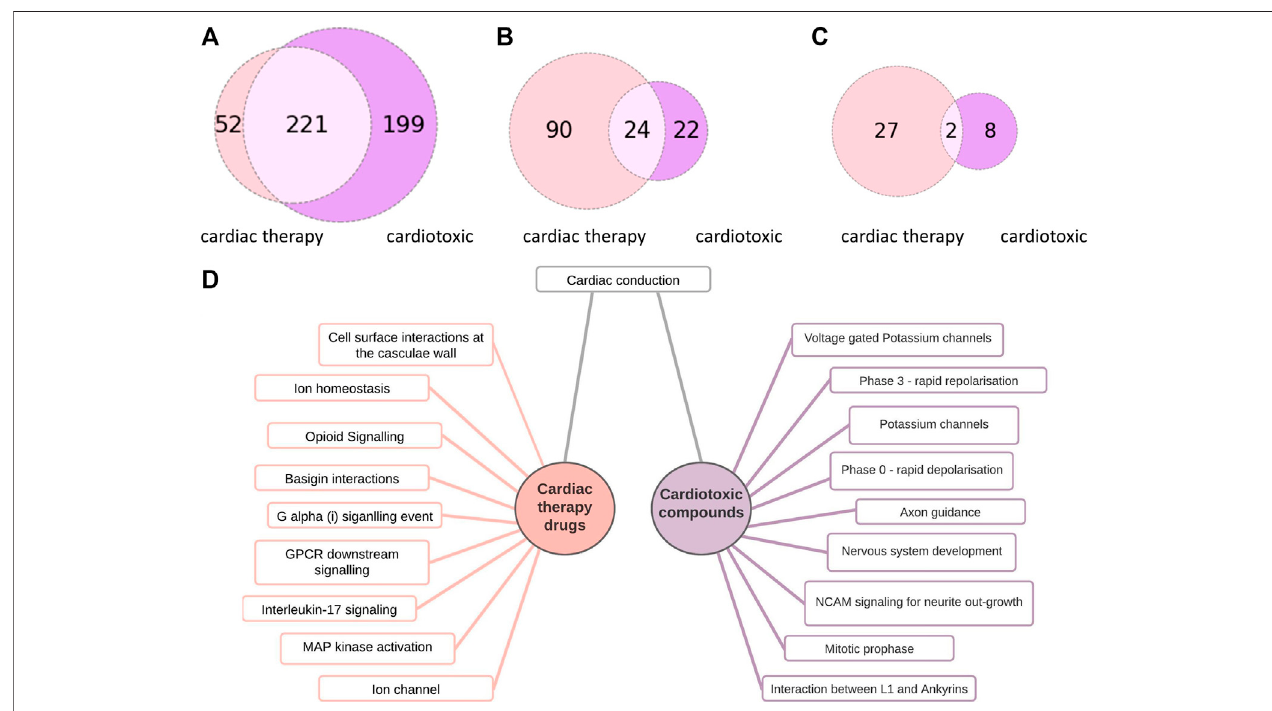
FIGURE 5 | Comparison ofpathways connected to cardiac therapy drugs and cardiotoxic drugs (A) : Number of pathway connections with an FDR cut-off of 0.05 between thecardiac therapy (light pink) and thecardiotoxic (purple) groups, (B) : Number ofpathwaysaffected by at least 10% ofcardiac therapy (light pink) and at least 10%ofcardiotoxiccompounds (purple),24commonpathways (C) :Numberofpathways affectedbyatleast20%ofcardiactherapy(lightpink) andatleast20%ofthe cardiotoxic (purple) compounds, 2 common pathways (D) :10 of the most often occurring pathways connected to cardiac therapy drugs (left) and to cardiotoxic drugs (right).